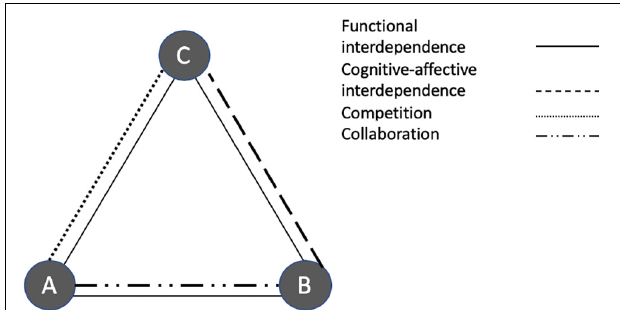
FIGURE 1 | Visual illustration of the interdependences and relationships between the three actors in the